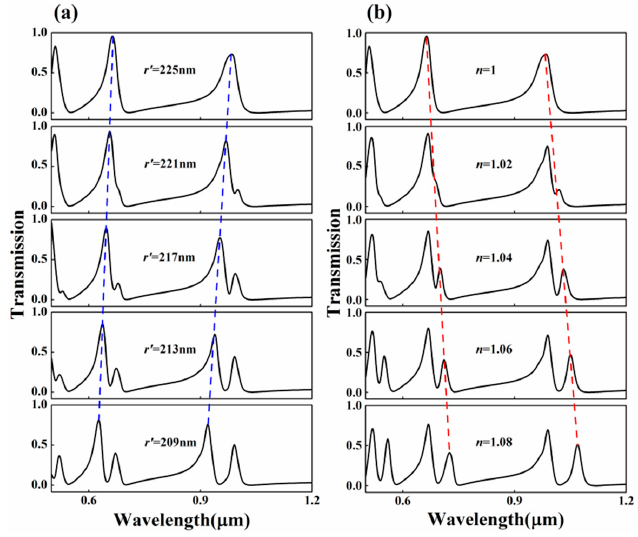
Figure 3. Transmission spectra of two shunt-wound rings system ( a ) for different radius r ’ of the lower ring; ( b ) for different refractive index n of the lower ring.